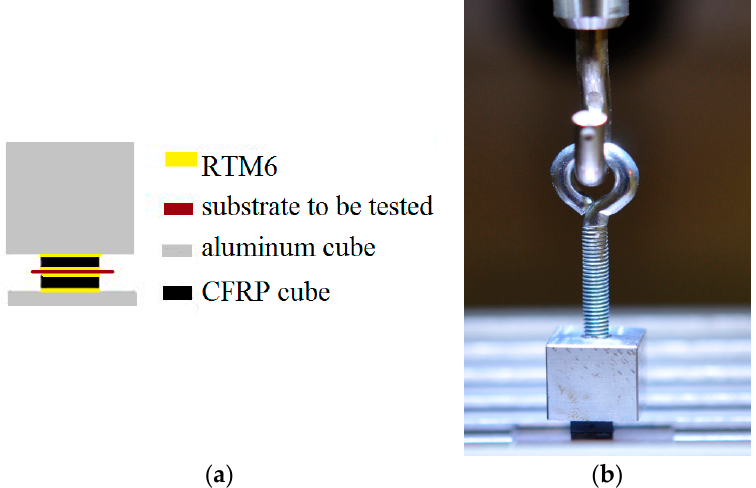
Figure 3. ( a ) Preparing adhesion test specimens. ( b ) The hook of the XYZTech multi tester machine for pulling test of 10 specimens from each